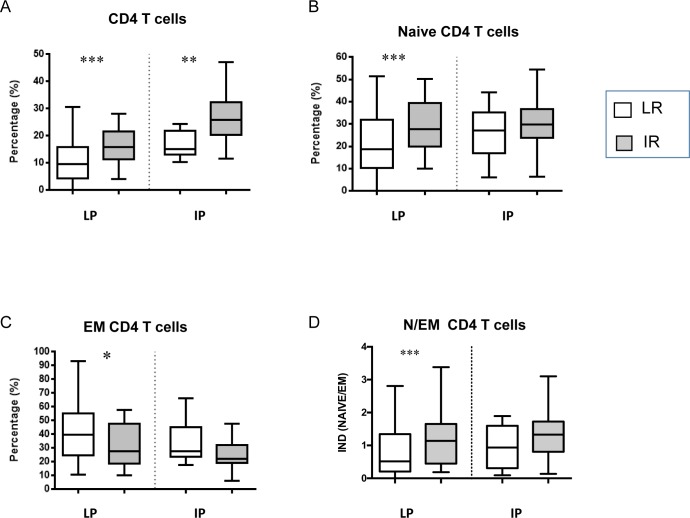
CD4 T cell differentiation was associated with immunological response to treatment.The frequency of total (A), naïve (B), EM (C) CD4 T cells and the N/EM CD4 T cell ratio (D) was analyzed before (w0) and after (w24) treatment in immunological responders (IR, grey bars) and in immunological low responders (LR, white bars). Results are shown as Box and Whiskers graphs. The parametric Wilcoxon test was used and p<0.05 was considered significant.